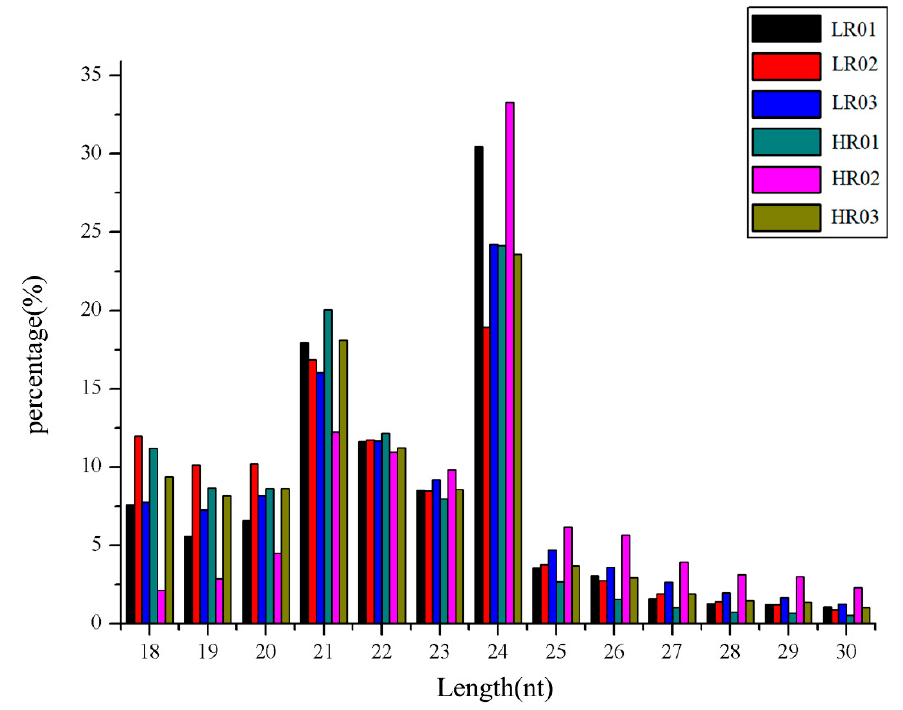
Figure 1. Length distribution and frequency of small RNAs (sRNAs) in the six Eucommia ulmoides